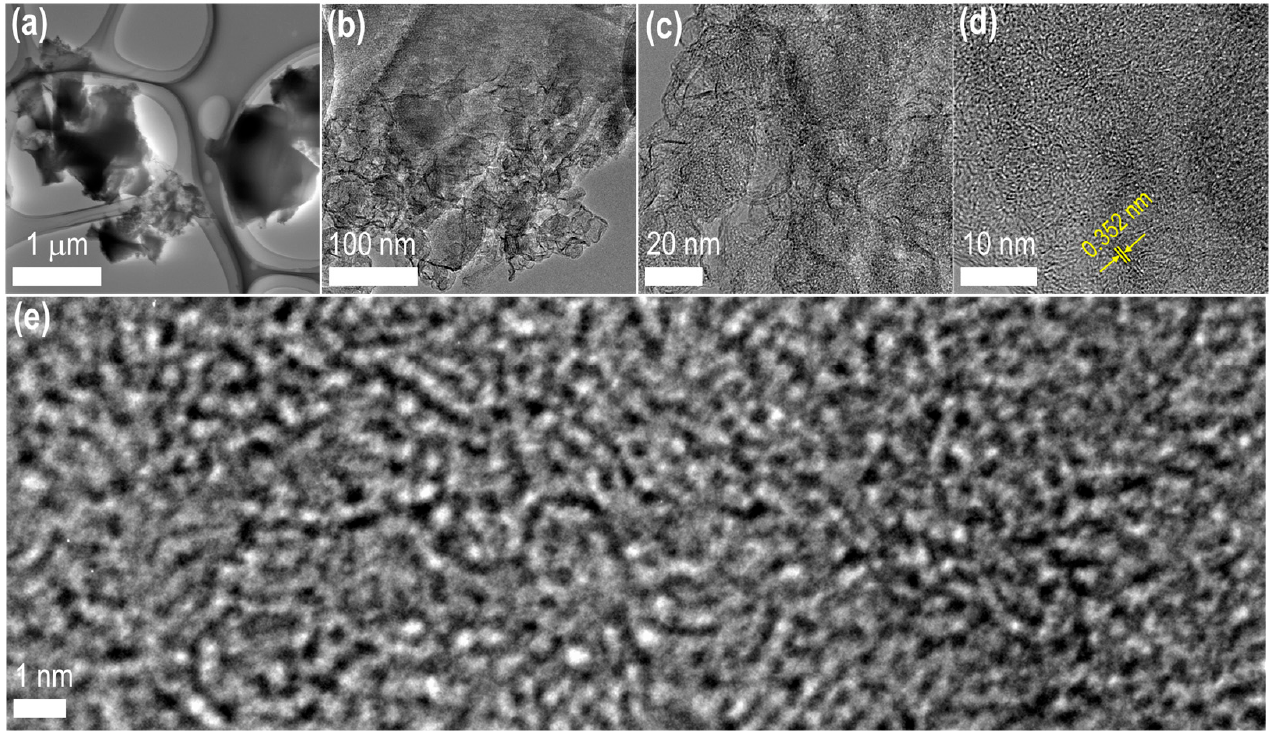
9 of 16 Figure 4. Surface morphology of the Amala seed carbons: SEM images of ( a – c ) AmP_900; ( d – f ) AmC_K700; ( g – i ) AmC_K800; ( j – l ) AmC_K900; and ( m – o ) AmC_K1000. As the SEM observed, TEM images (Figure 5) show a well-developed micro/mesopo- rous structure. Carbon particles of a few microns in size, with a porous structure, can be witnessed in the low-resolution TEM image (Figure 5a). Due to thick carbon particles, only some of the pores are visible. The bright portion in this image refers to the porous struc-